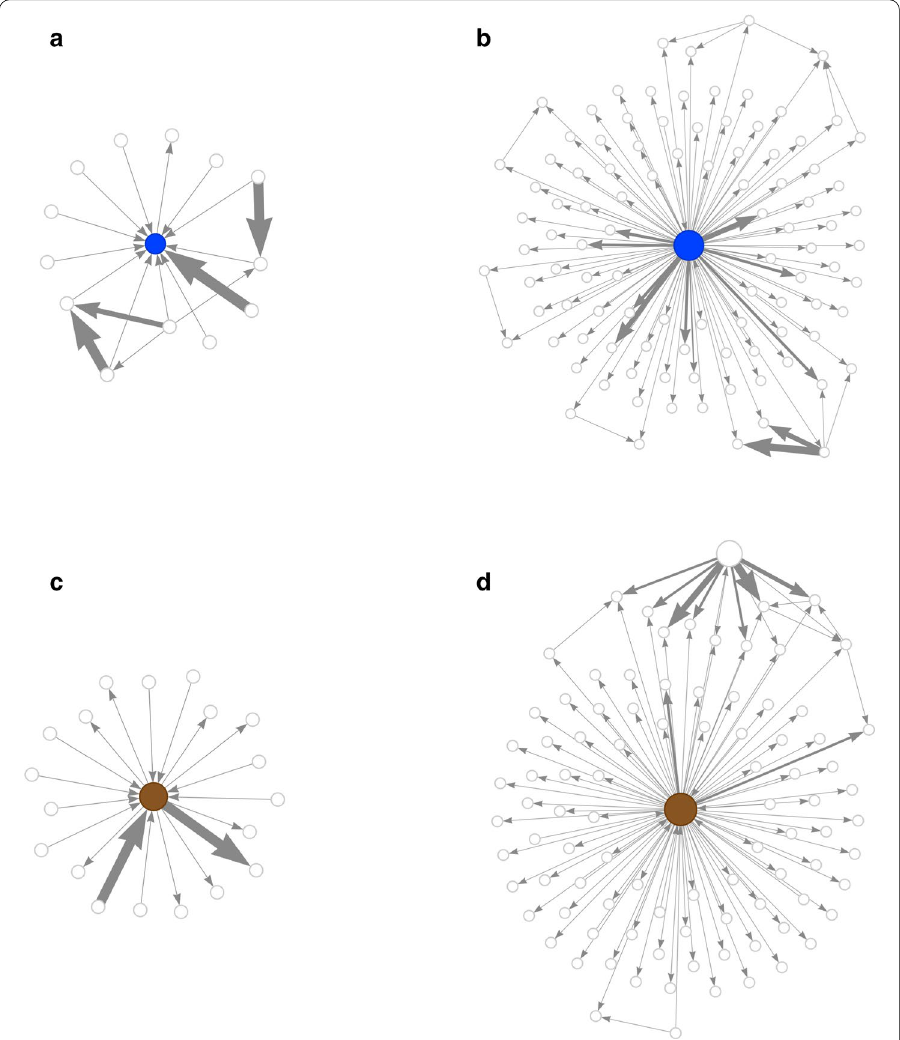
Fig. 1 Examples of egocentric networks. a , b Egocentric networks of arbitrarily selected two normal users. c , d Egocentric networks of arbitrarily selected two fraudulent users involved in selling a fictive